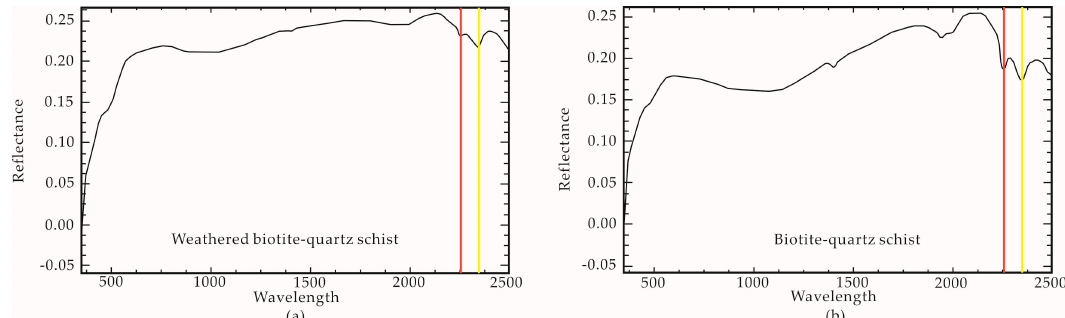
Figure 9. Spectral curve of weathered biotite–quartz schist and fresh biotite–quartz schist acquired by ASD Field spec-FRTM spectroradiometer in July 2015. There were two pronounced emittance minima marked by different colored lines. ( a ) Spectral curve of weathered biotite–quartz schist; and ( b ) spectral curve of fresh biotite–quartz schist.